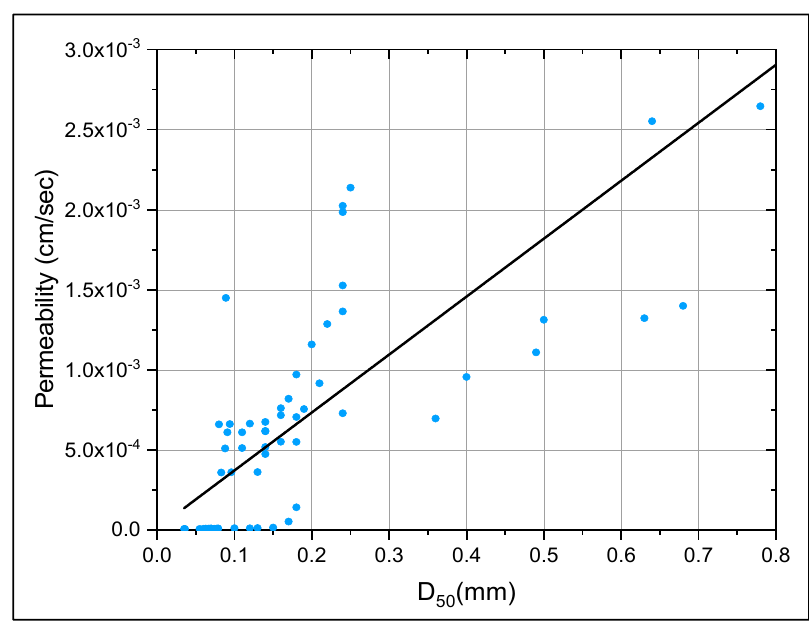
Figure 8. Permeability versus D 50 .